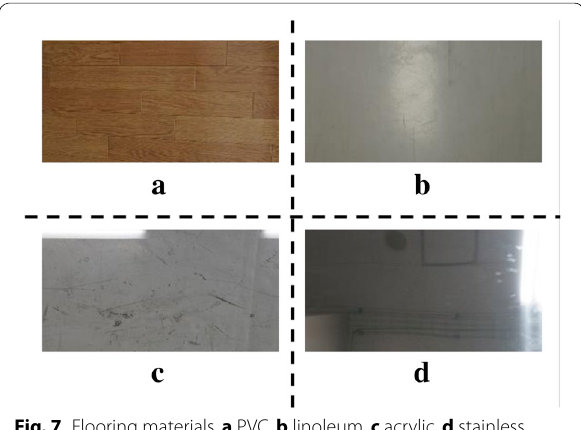
Fig. 7 Flooring materials. a PVC, b linoleum, c acrylic, d